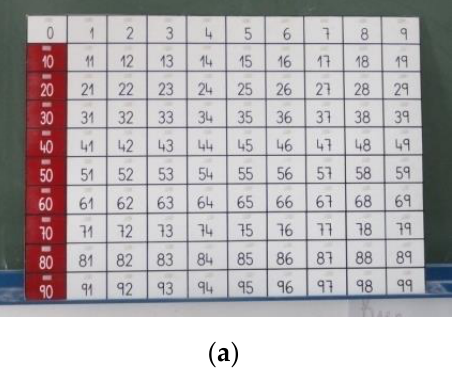
Figure 2. ( a ) Collective numerical panel; ( b ) Personal numerical panel.